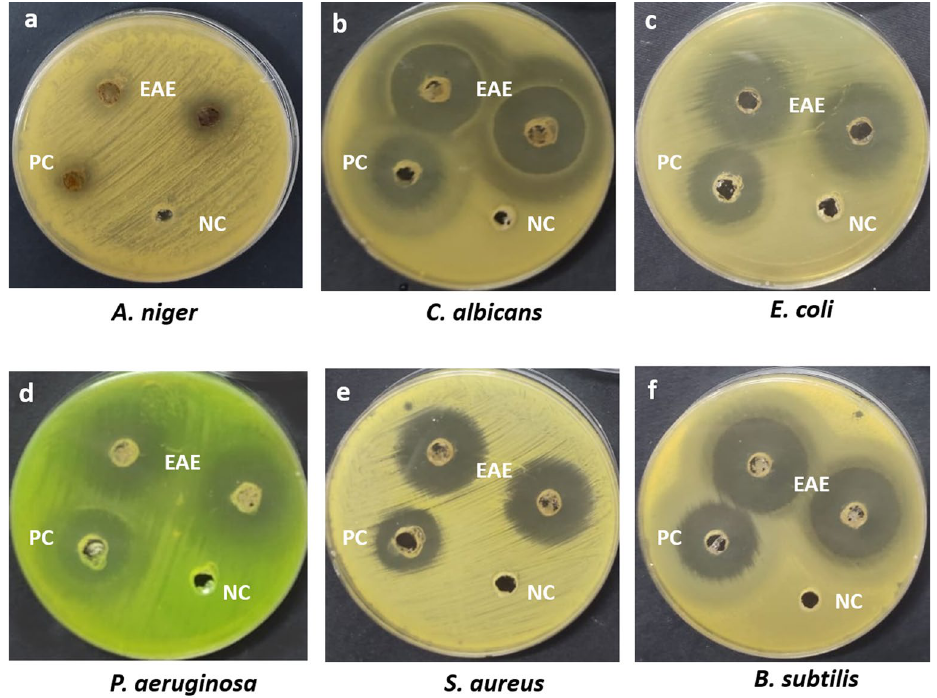
Figure 2. The inhibition zone (mm) of ethyl acetate crude extract (EAE) of Paecilomyces sp. (AUMC-15510) at a concentration of 5 mg/ml against ( a ) A. niger ( b ) C. albicans ( c ) E. coli ( d ) P. aeruginosa ( e ) S. aureus , and ( f ) B. subtilis . PC: Fluconazole and Gentamicin at concentration of 5 mg/ml (positive control); NC: 10% DMSO (negative control).